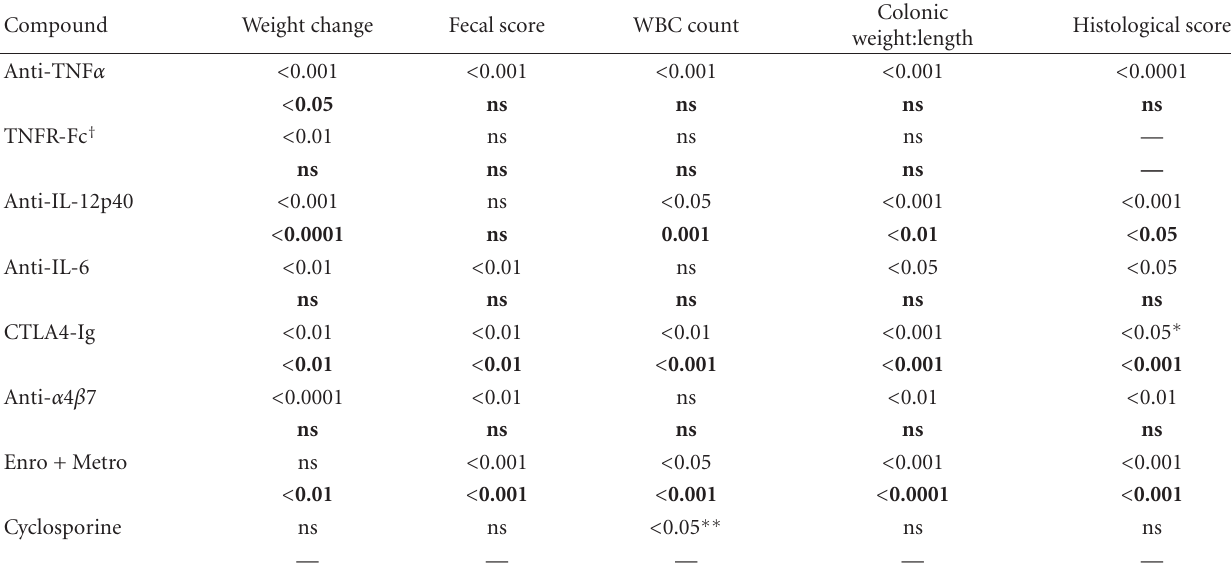
† Prevention = 50mg/kg, intervention = 5mg/kg. ∗ Used Wilcoxon signed rank test and compared with a hypothetical value of 0.0 since all scores were 0 in the CTLA4-Ig group. ∗∗ WBC count higher in treatment group—not